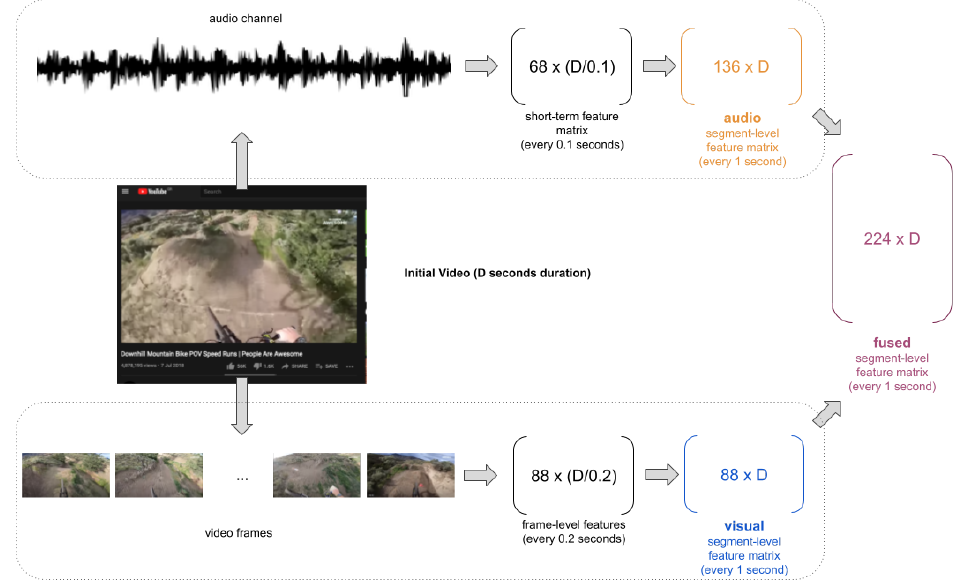
Figure 1. Conceptual diagram of the feature extraction process for both audio and visual